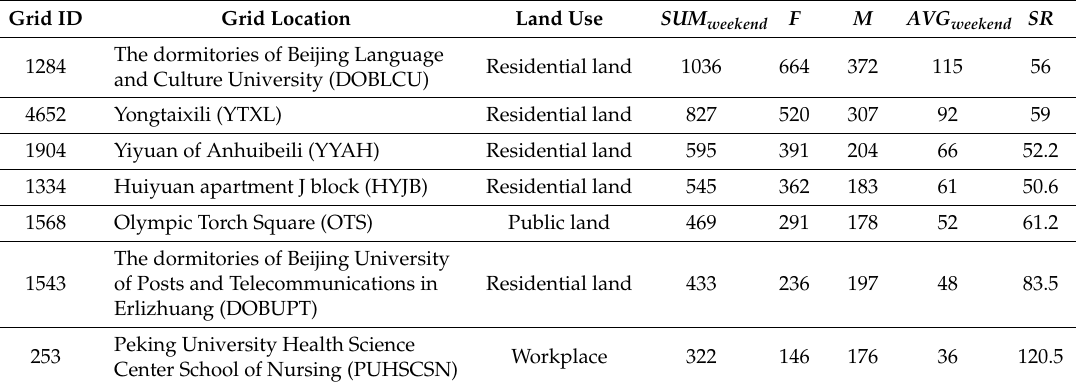
Table 4. The partial statistical results of the quantities of users on weekends in June